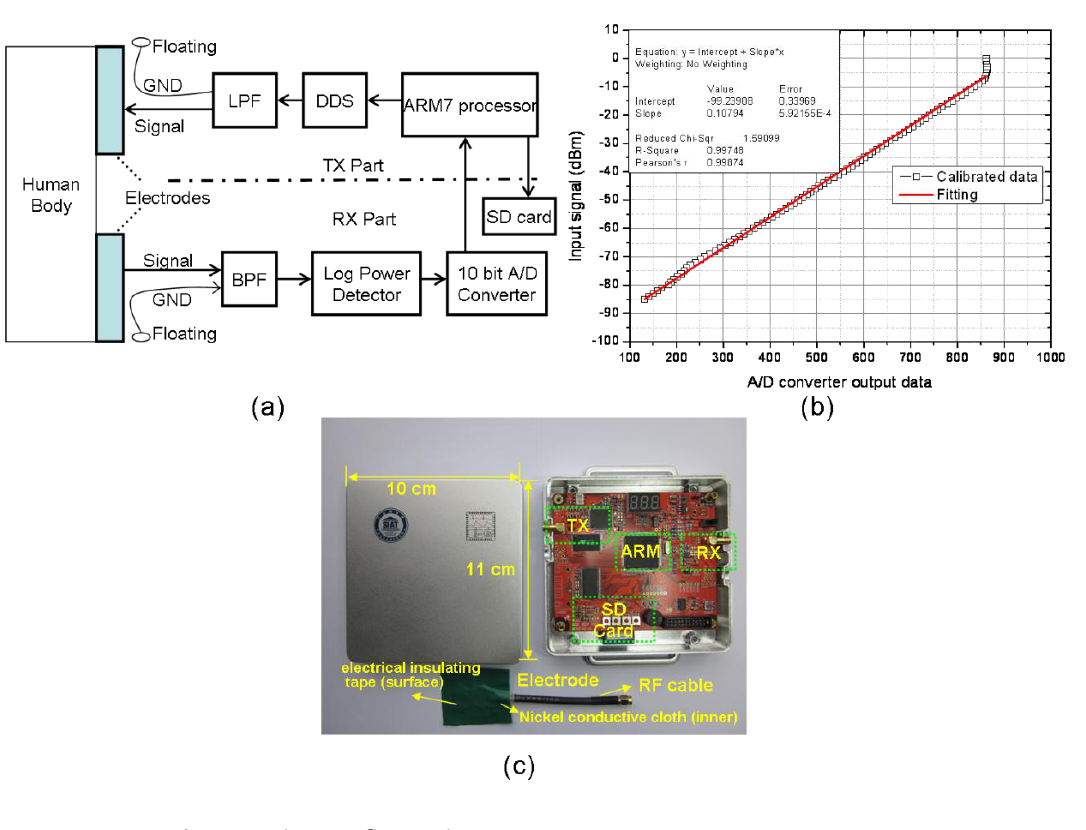
Figure 1. ( a ) Functional block diagram of the measurement system, ( b ) Calibration between the input signal (dBm) and the digital output from the 10-bit A/D converter, ( c ) Top view of transmitting/receiving module with an electrode connected to